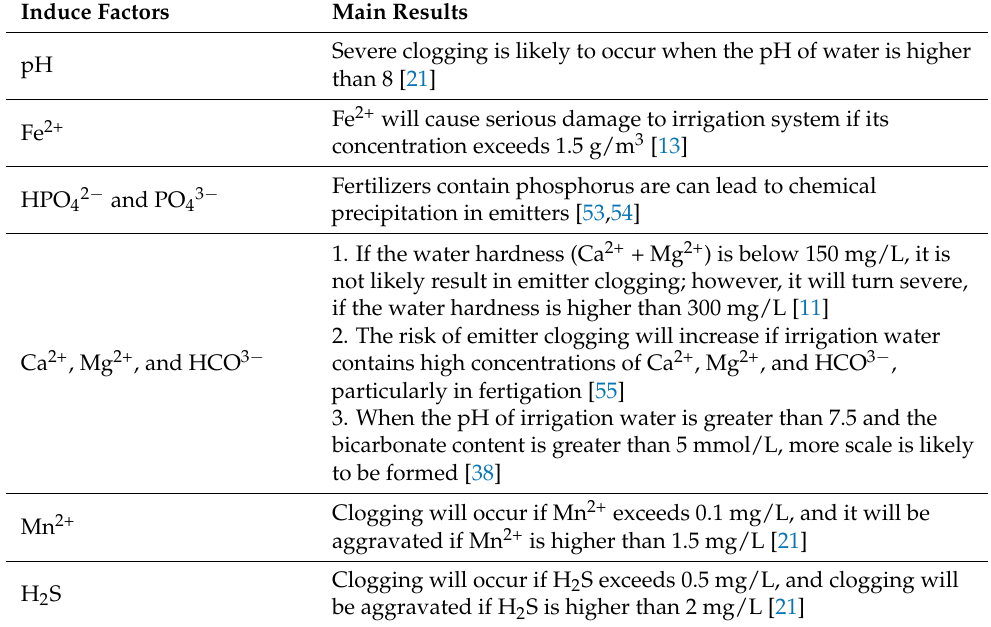
Table 3. Emitter clogging caused by soluble substances in water sources.